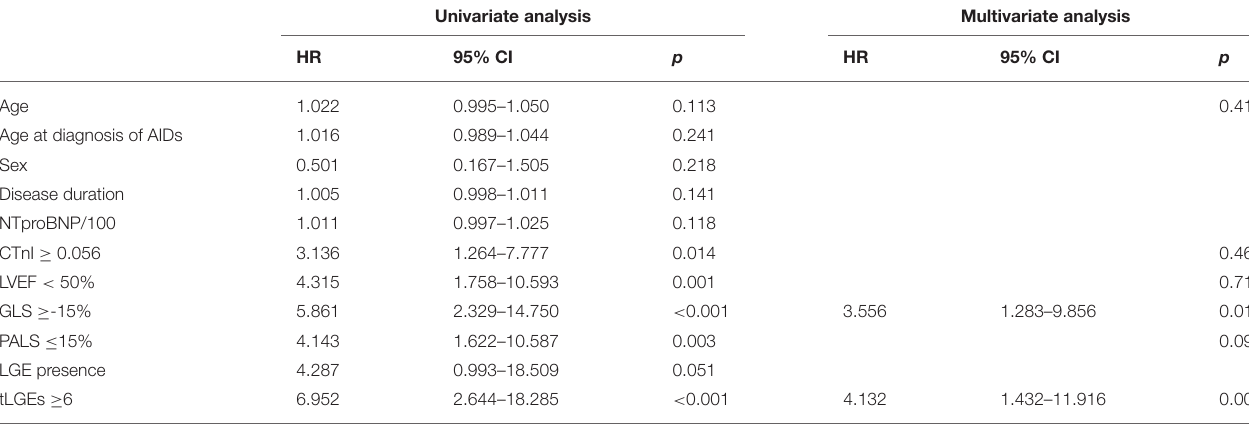
TABLE 5 | Univariate and multivariate Cox regression analyses for predictors of the primary endpoint. Univariate analysis